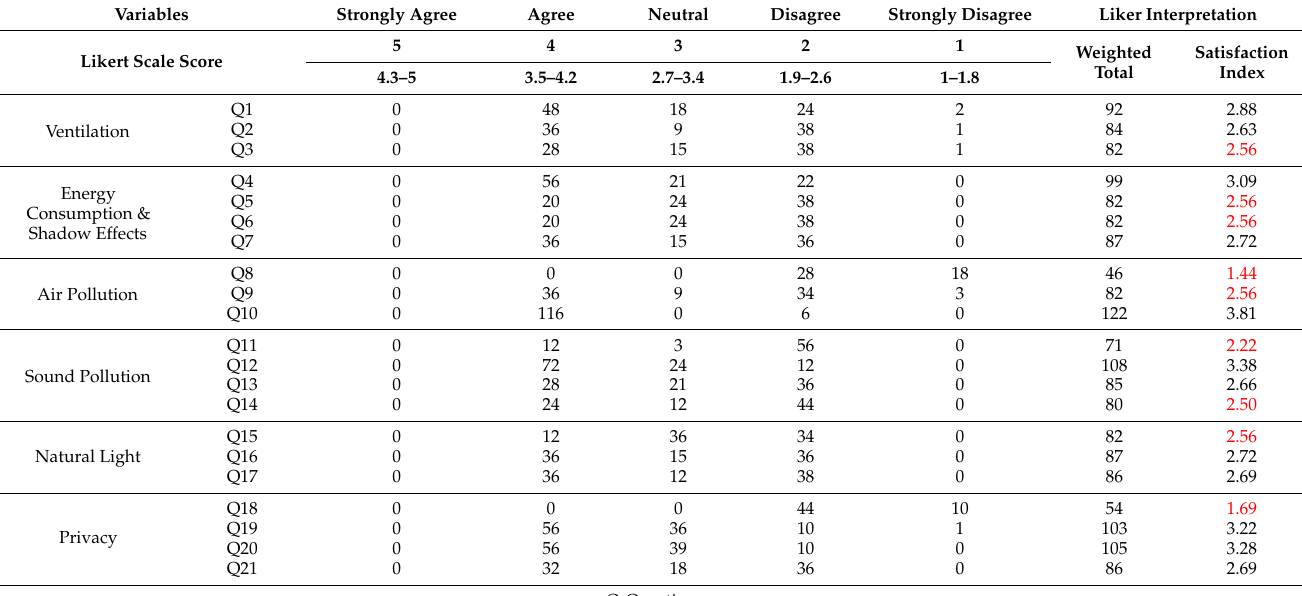
Table 9. Analysis of residents’ opinion based on Likert